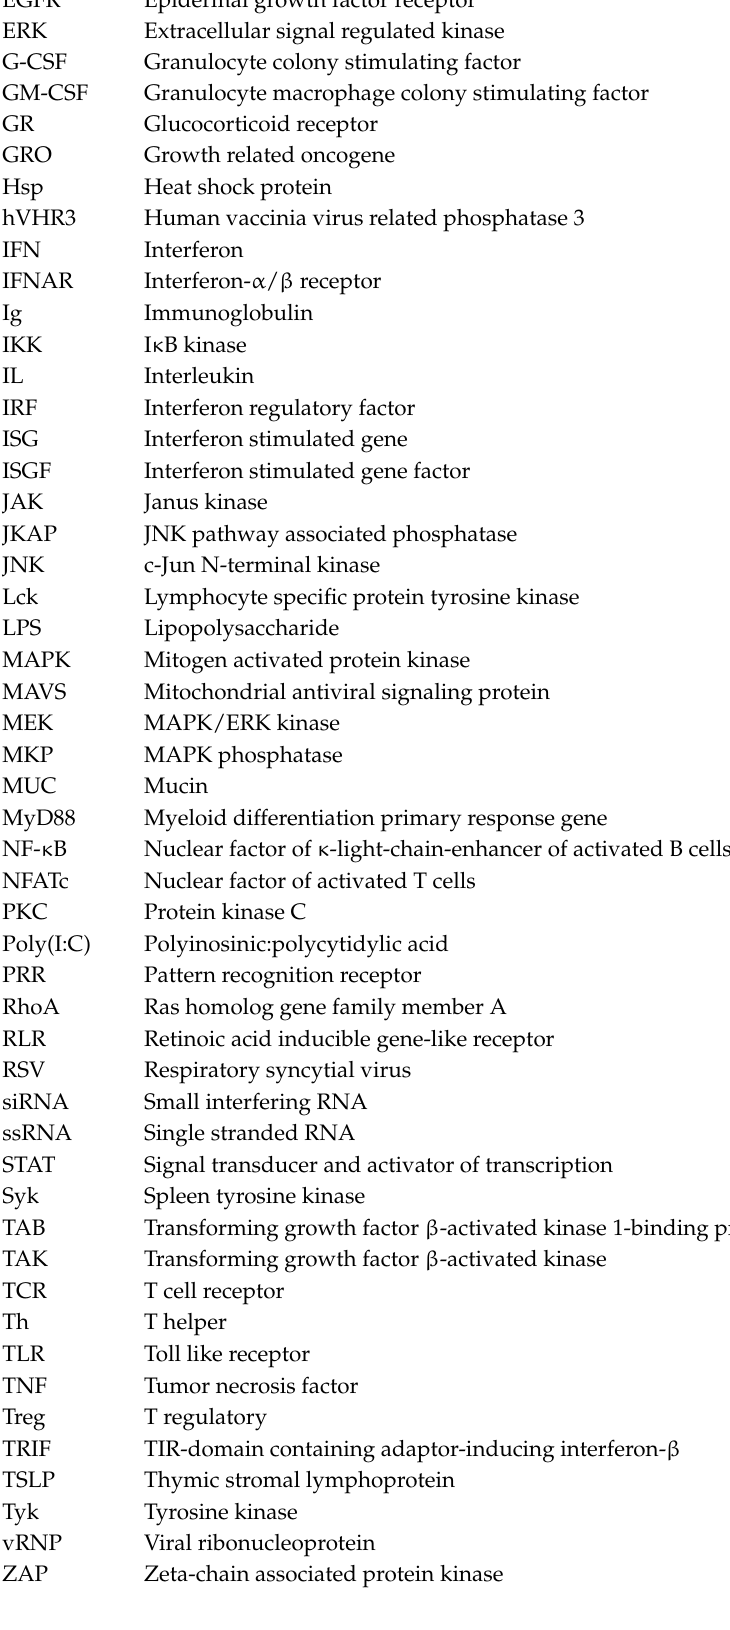
Transforming growth factor β -activated kinase 1-binding